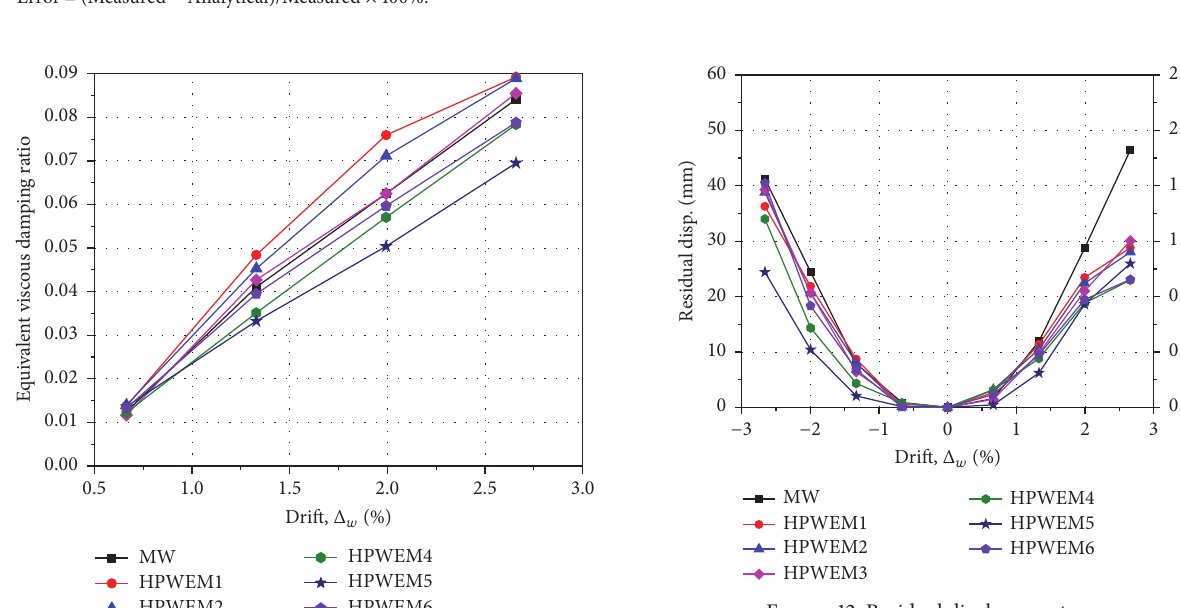
Figure 12: Residual displacement